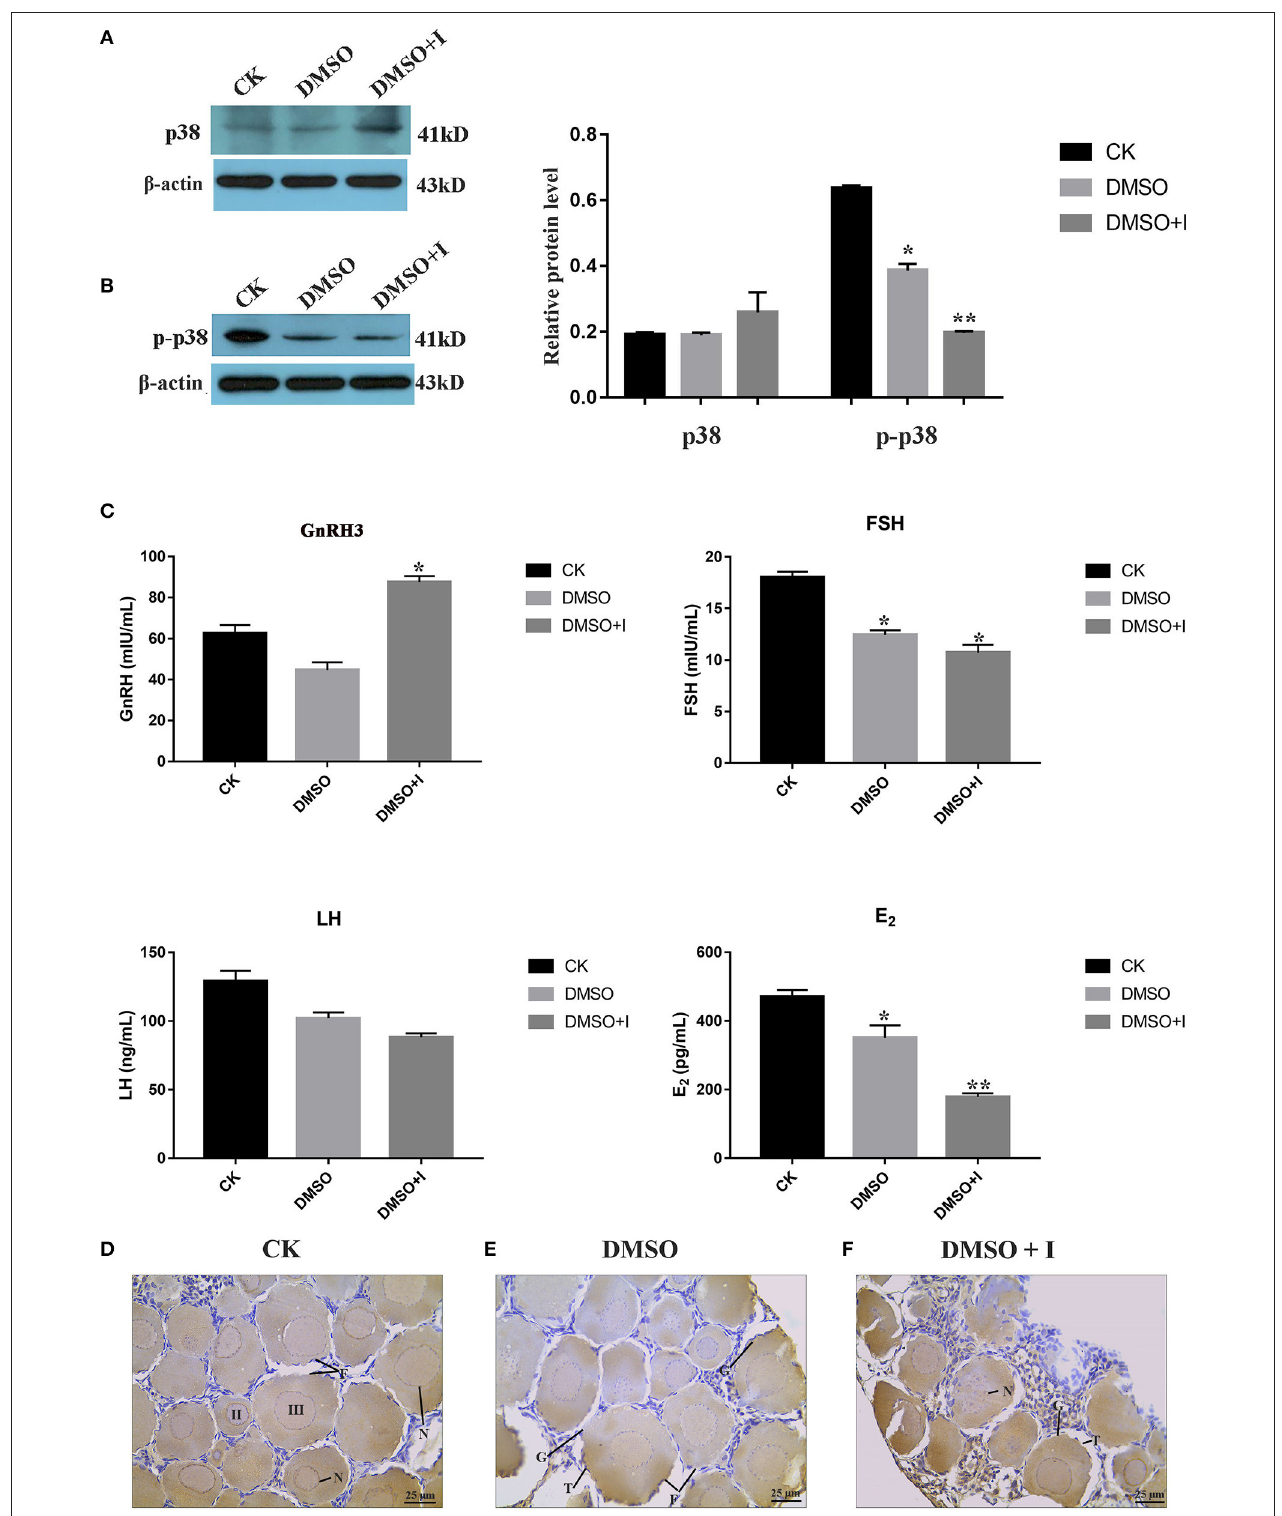
FIGURE 7 | Effects of p38 MAPK on ovarian development of B. lenok . (A) The expression level of p38 MAPK protein in ovary; (B) The phosphorylation level of p38 MAPK protein in ovary of different groups; (C) The level of HPG hormones of different groups; The significance was expressed “*” as a P -value of < 0.05 vs. CK group, and “**” as a P -value of < 0.01 vs. CK group. (D–F) Ovarian morphology of different groups observed by immunohistochemistry. II, oocyte of phaseII; III, oocyte of phase III; F, follicle; T, theca cell; G, granulosa cell; N, nucleus.